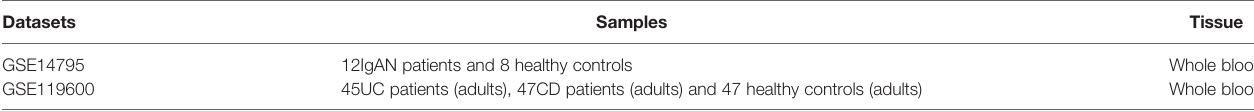
TABLE 1 | The information of samples used to analysis.